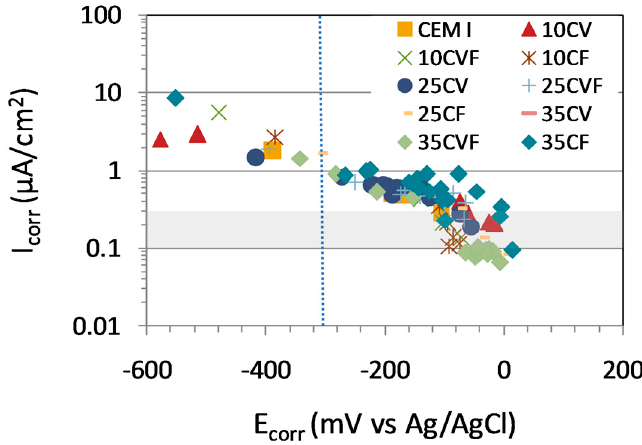
Figure 8. Relationship between I corr and E corr during the transition from a passive to an active state. Data of all the samples are considered before and after depassivation.